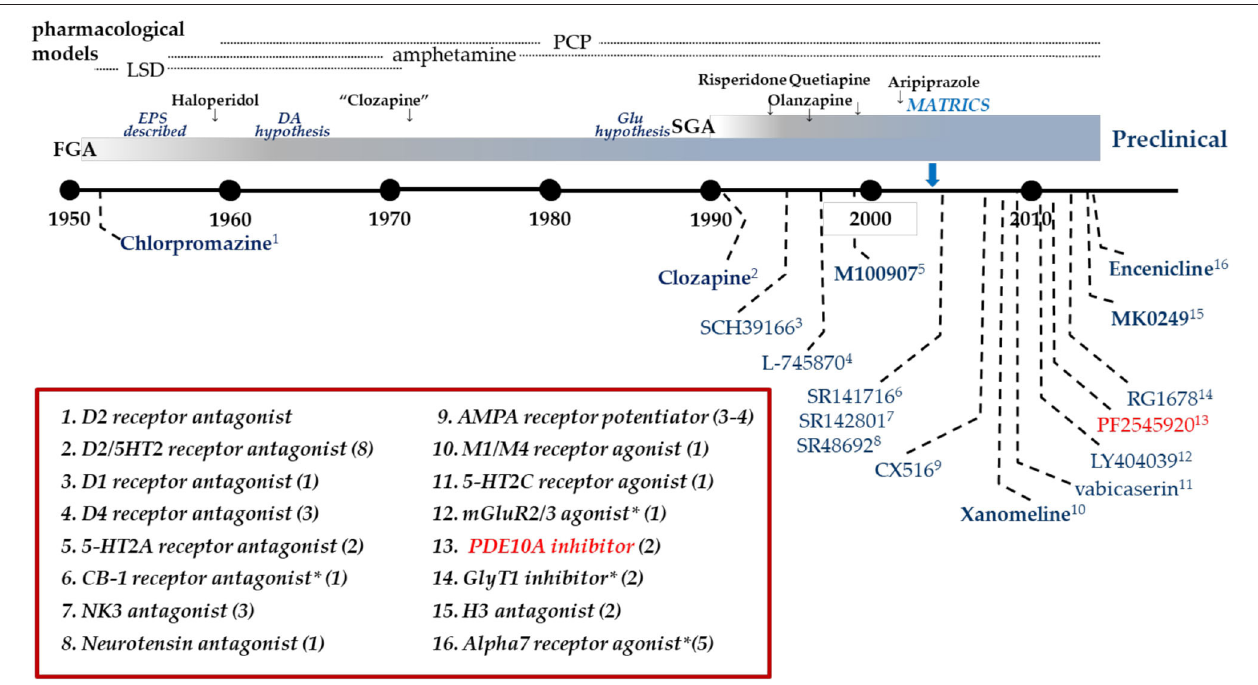
FIGURE 1 | Clinical drug development in Schizophrenia. Timeline of clinical drug development in schizophrenia following the discovery of the antipsychotic activity of chlorpromazine in 1952. Individual compounds are listed in the graphic with their pharmacological mechanism identified in the box. Many mechanisms have been targeted with multiple compounds as identified by the value in parentheses. Dates are an approximation, based on publication dates or drug approval. *Includes allosteric